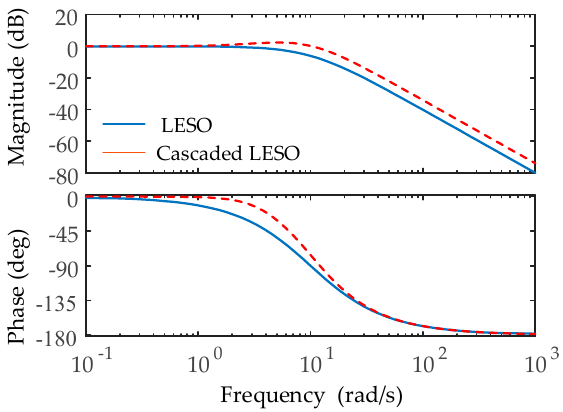
Figure 6. Comparison of disturbance estimation performance between conventional ESO and cas- caded LESO.